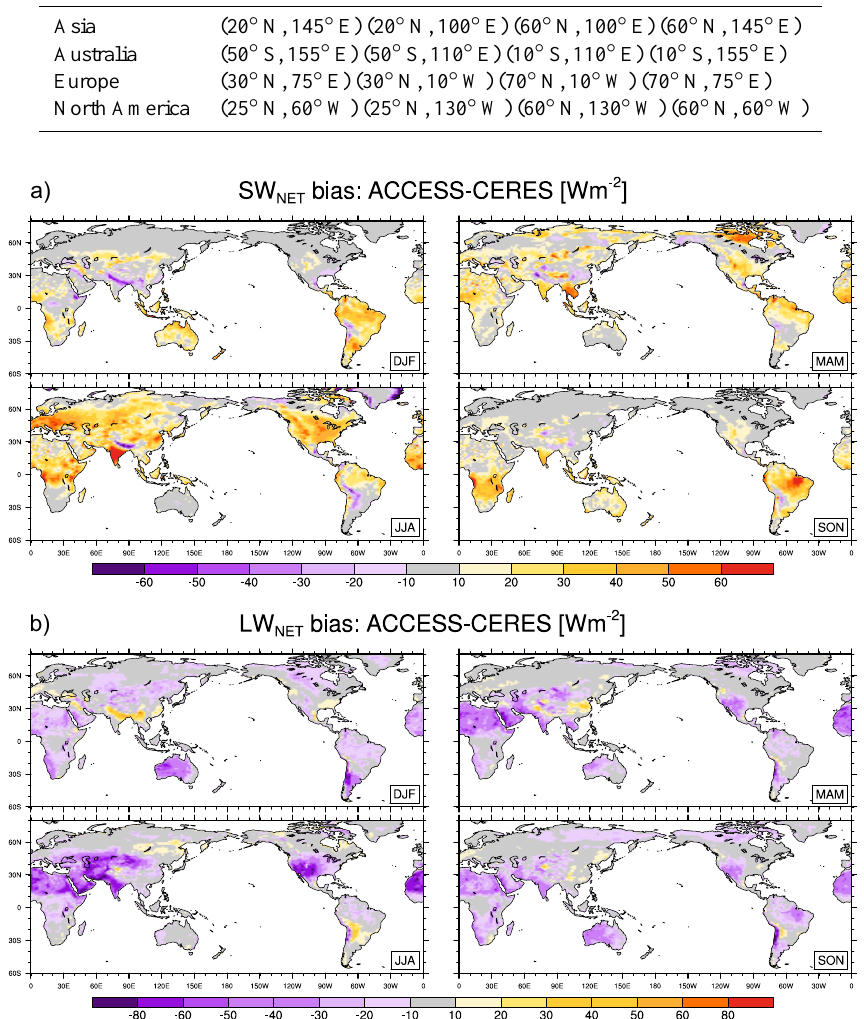
Fig. 11. Biases between ACCESS1.3b and CERES in net shortwave radiation (a) and net longwave radiation (b) . The considered time period is the overlapping time period between model run and observations,